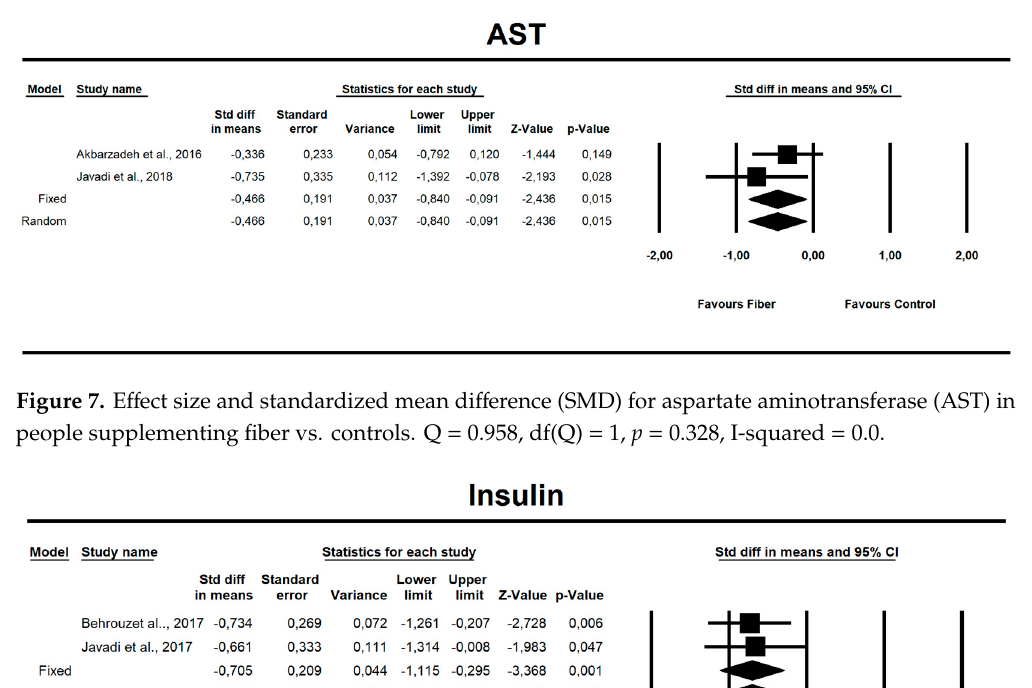
Figure 6. Effect size and standardized mean difference (SMD) for alanine aminotransferase (ALT) in people supplementing fiber vs. controls. Q = 0.118, df(Q) = 1, p = 0.732, I-squared = 0.0.